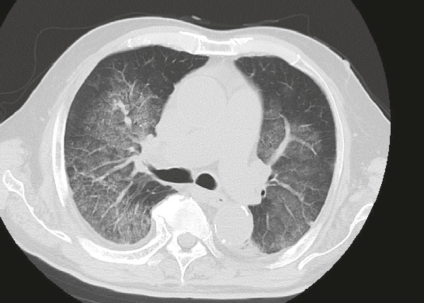
Figure 2: Chest computed tomography findings on admission. High-resolution computed tomography of the chest shows reticular opacity with bronchial-wall thickening and interlobular septal thickening in both lung